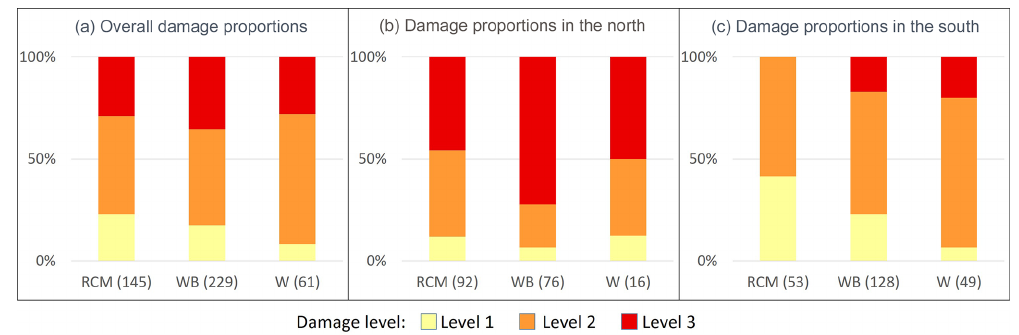
Figure 4. Damage-type proportion statistics of the three major structural types in 2008. The numbers in parentheses under the x axis indicate the total number of buildings. (a) Damage-type proportions of all the earthquake-affected buildings. (b) Damage-type proportions on the northern side of the thick dotted line in Fig. 3. (c) Damage-type proportions on the southern side of the thick dotted line in Fig. 3.